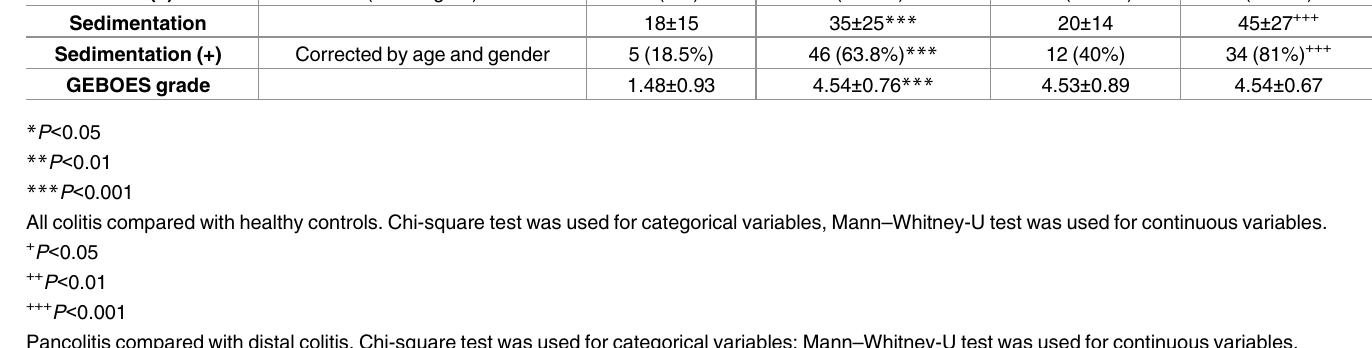
Healthy All colitis (n = 72) Distal colitis (n = 27)